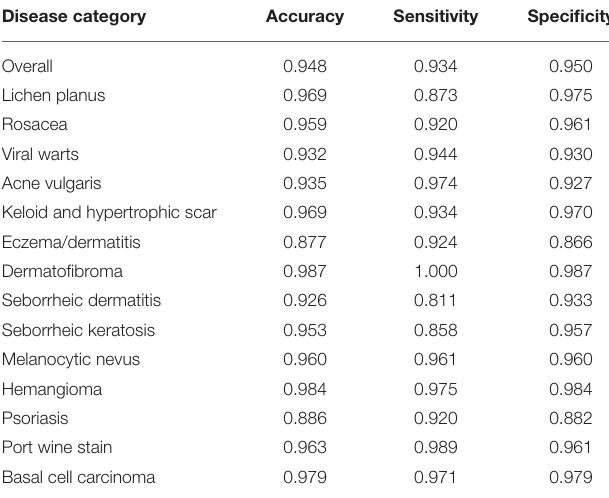
TABLE 2 | The classification accuracy, sensitivity and specificity of the proposed CNN model according to disease